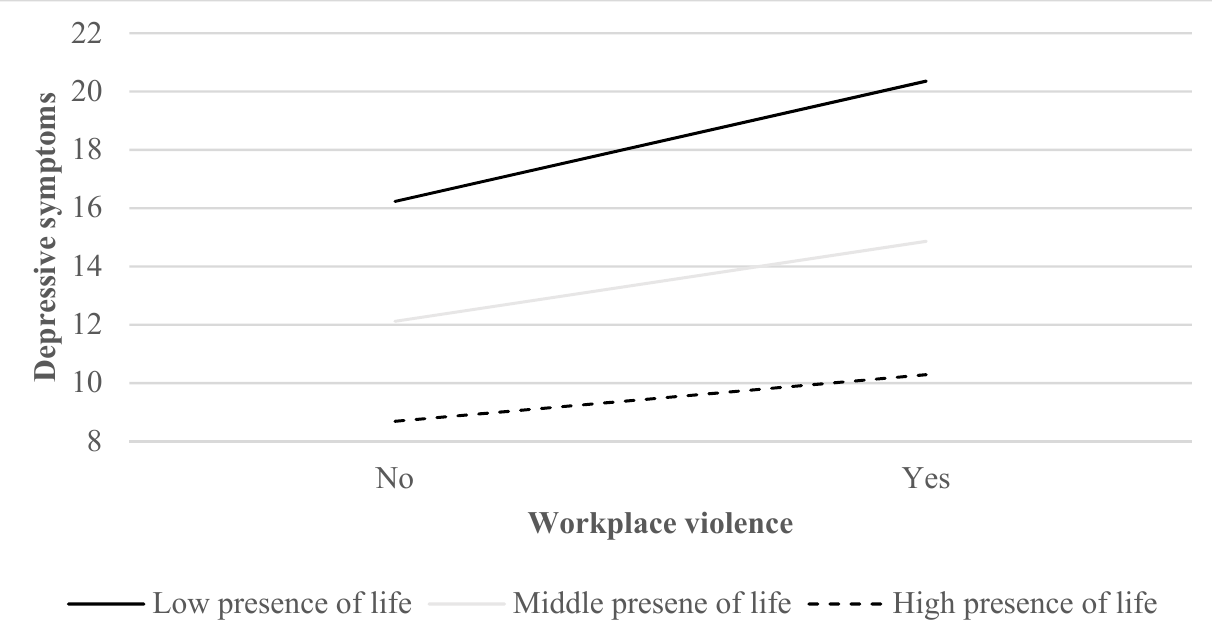
Figure 2. Presence of life moderated the relationship between workplace violence and depressive symptoms among primary health care professionals.